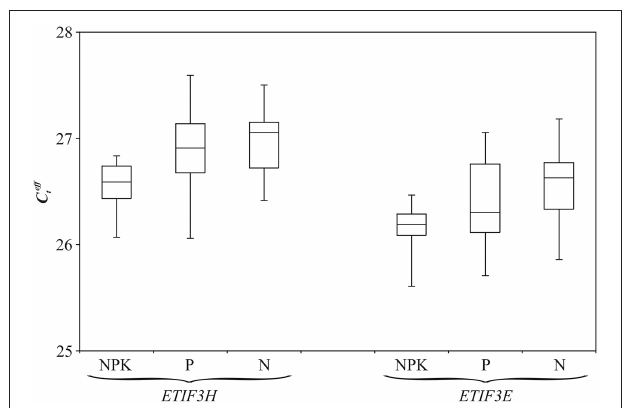
FIGURE 3 | Distribution of C eff t values for ETIF3H and ETIF3E genes under excess nutrients (NPK), Pi deficiency (P), and normal (N) conditions. Rectangles correspond to the range containing 50% of the values (between the 25th and 75th percentiles); the horizontal line inside the rectangle is the median value (the 50th percentile); the bars are the maximum and minimum C eff t values.